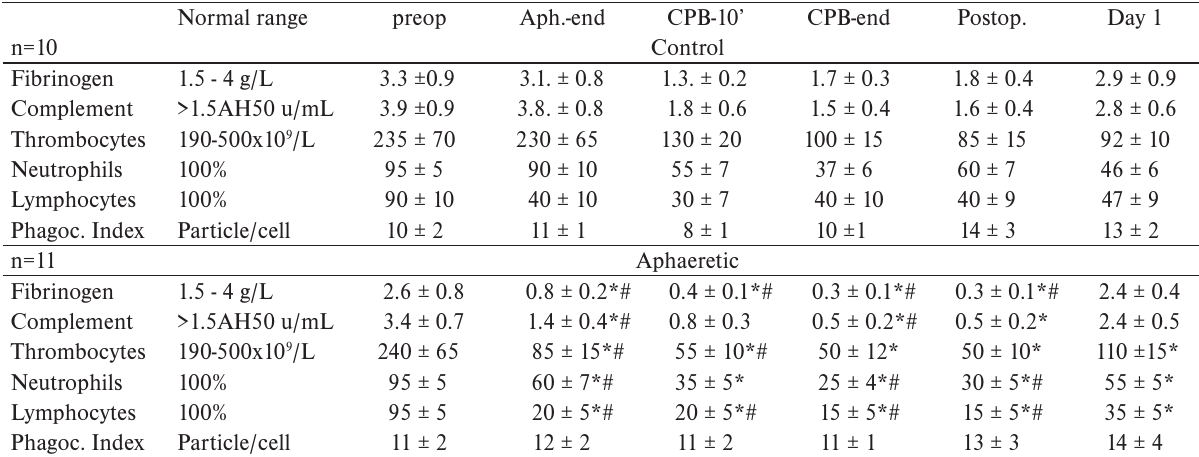
Table 2. perioperative data of animals.